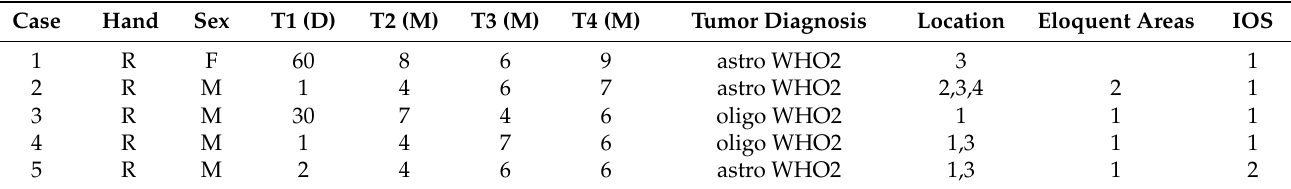
Table 1. Patients’ demographics and tumor features.